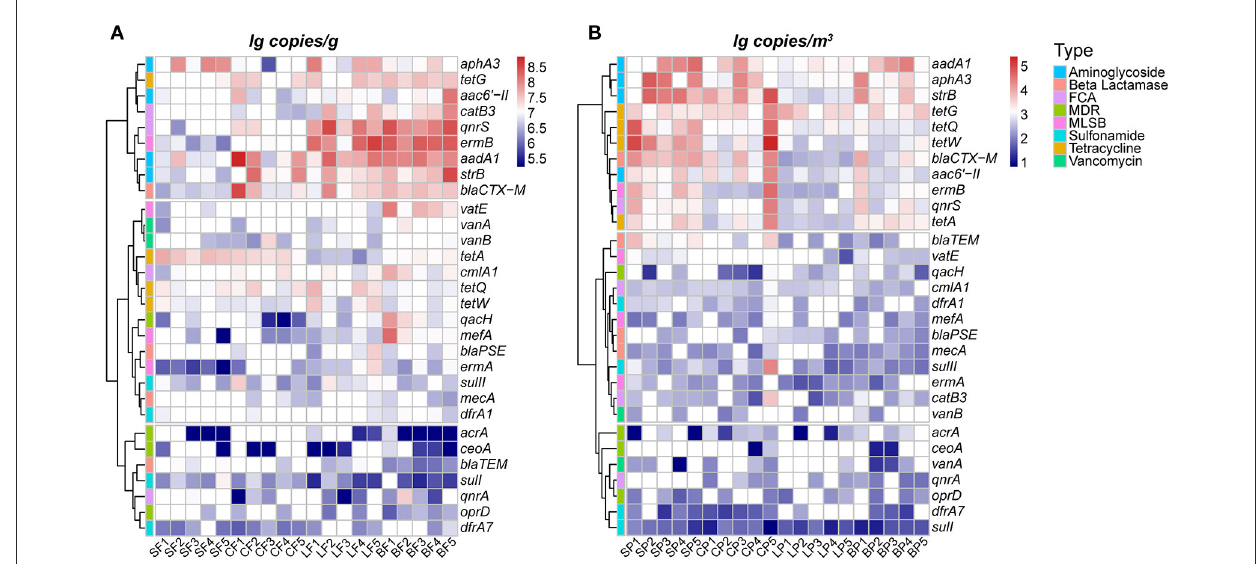
FIGURE1 Abundance (log 10 transformed concentration) of 30 ARGs subtypes in animal fecal (A) and PM2.5 (B) samples by animal species. The first letter of the sample name represents the category of animals: S, swine; C, cattle; L, layer; B, broiler. The second letter represents the category of media: F, feces; P,